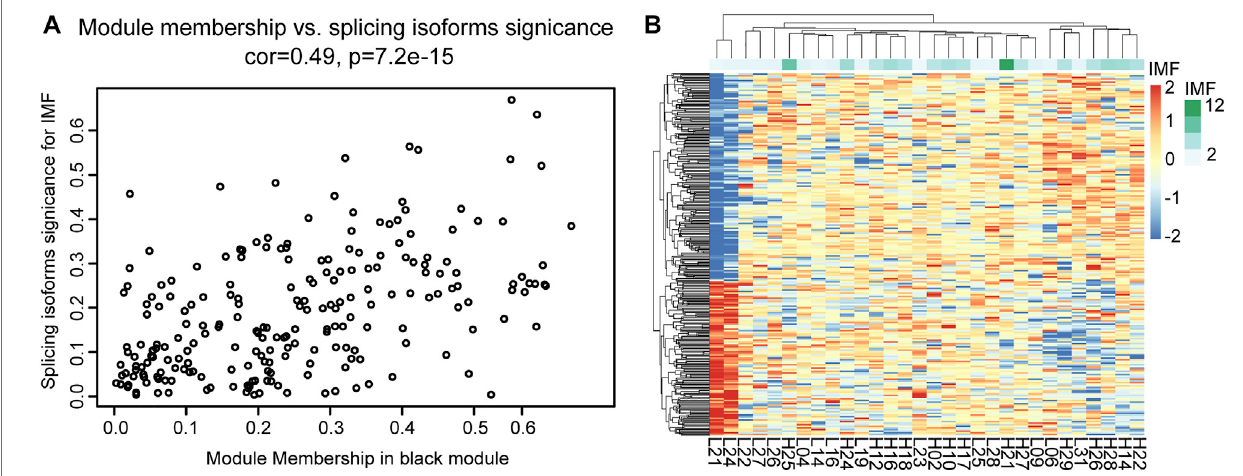
FIGURE 7 | Correlation analysis between MEblack and IMF. (A) Dot plot of correlation between splicing isoforms in MEblack and IMF; (B) Pheatmap of splicing isoforms in MEblack and 30 samples.